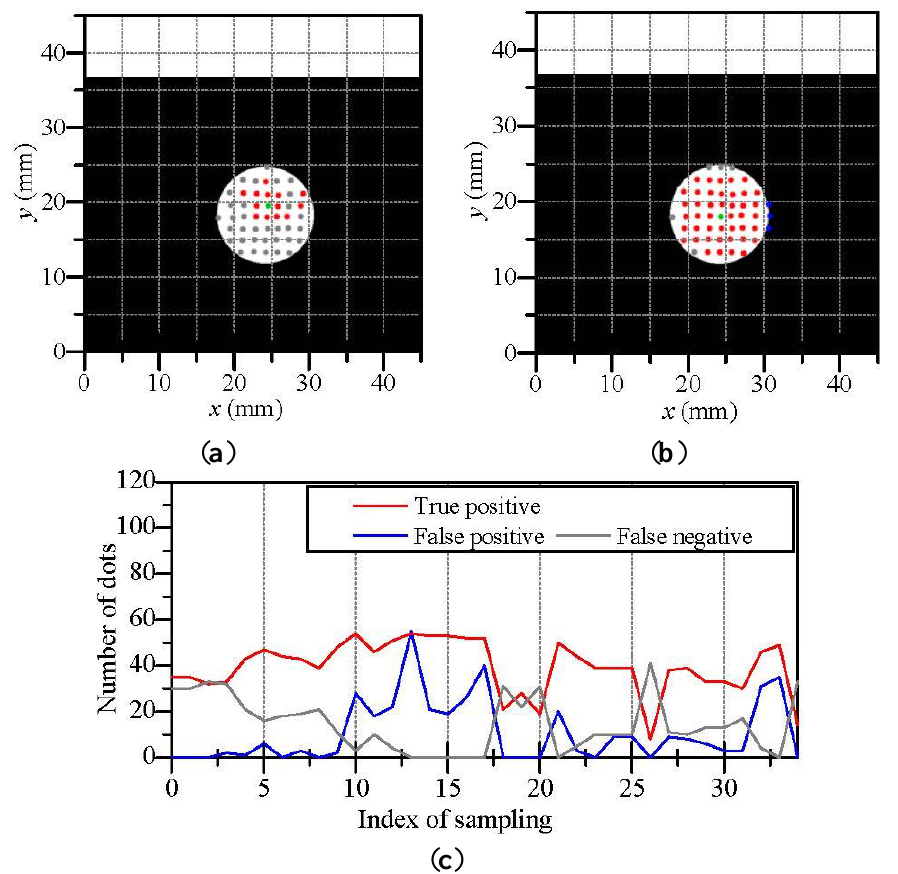
Figure 9. The estimation result of contact region when the touchpad contacted a cylinder-shaped object; ( a ) is a worse case; ( b ) is a better case; ( c ) is the variation of the estimation when the contact became increasingly